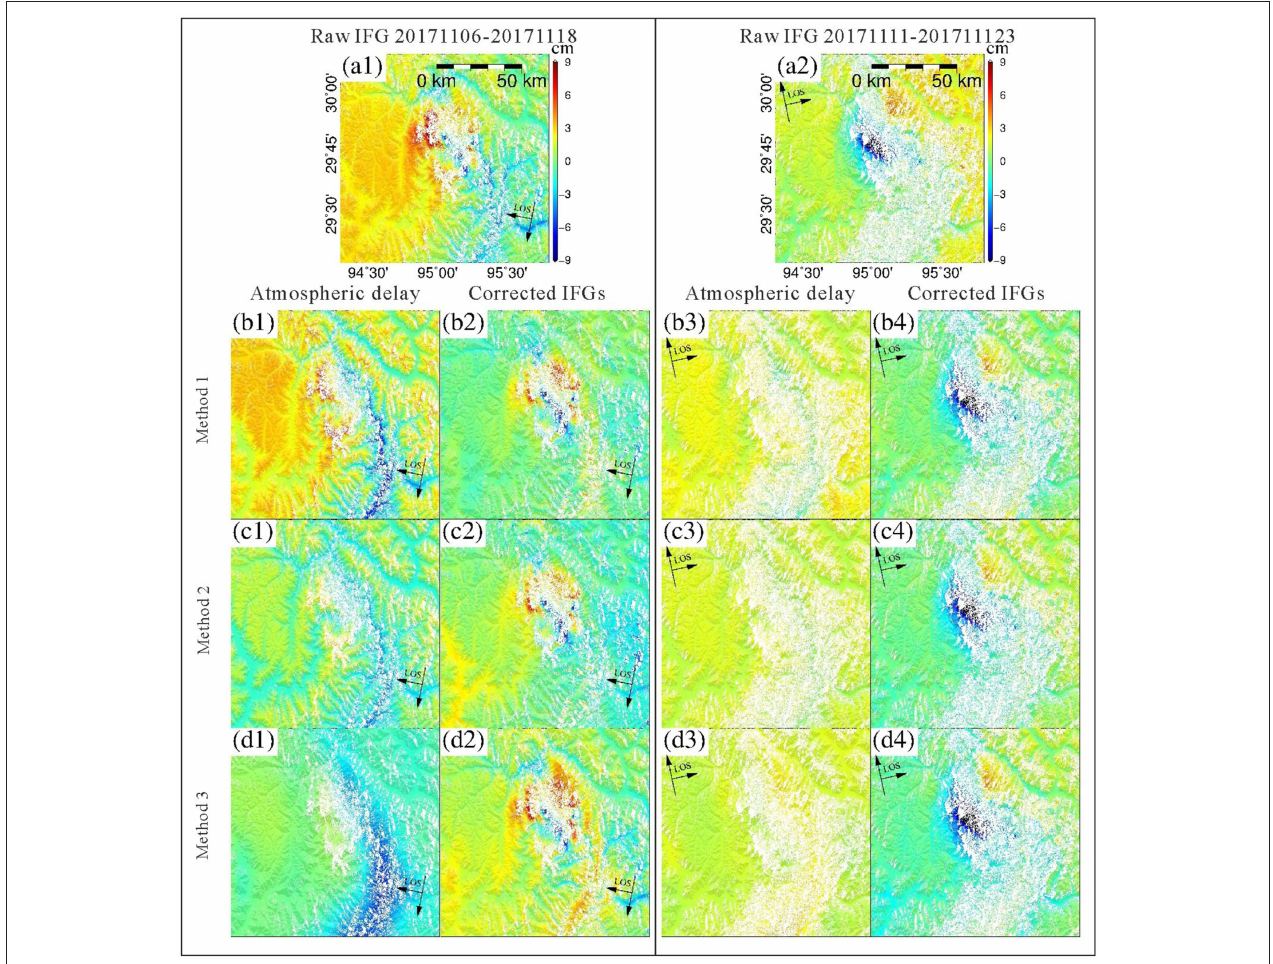
FIGURE 4 | (A1,A2) Uncorrected DInSAR LoS deformation (positive away from the radar) spanning the Mw 6.4 November 17, 2017 Nyingchi, China, earthquake. The descending pass image pair was acquired by Sentinel-1a on November 6th, 2017 and November 18th 2017. The ascending pass image pair was acquired by Sentinel-1a on November 11th, 2017 and November 23rd, 2017. (B–D) Estimated tropospheric delay and corrected LoS deformation using different data and methods: (B1–B4) HRES-ECMWF data interpolated with the Iterative Tropospheric Decomposition model (Yu et al., 2018). (C1–C4) Exponential model fitted to far-field DInSAR phase values. (D1–D4) HRES-ECMWF interpolated bilinearly. Reproduced from Figure 2 in Yu et al. (2018), distributed under the CC BY 4.0 license